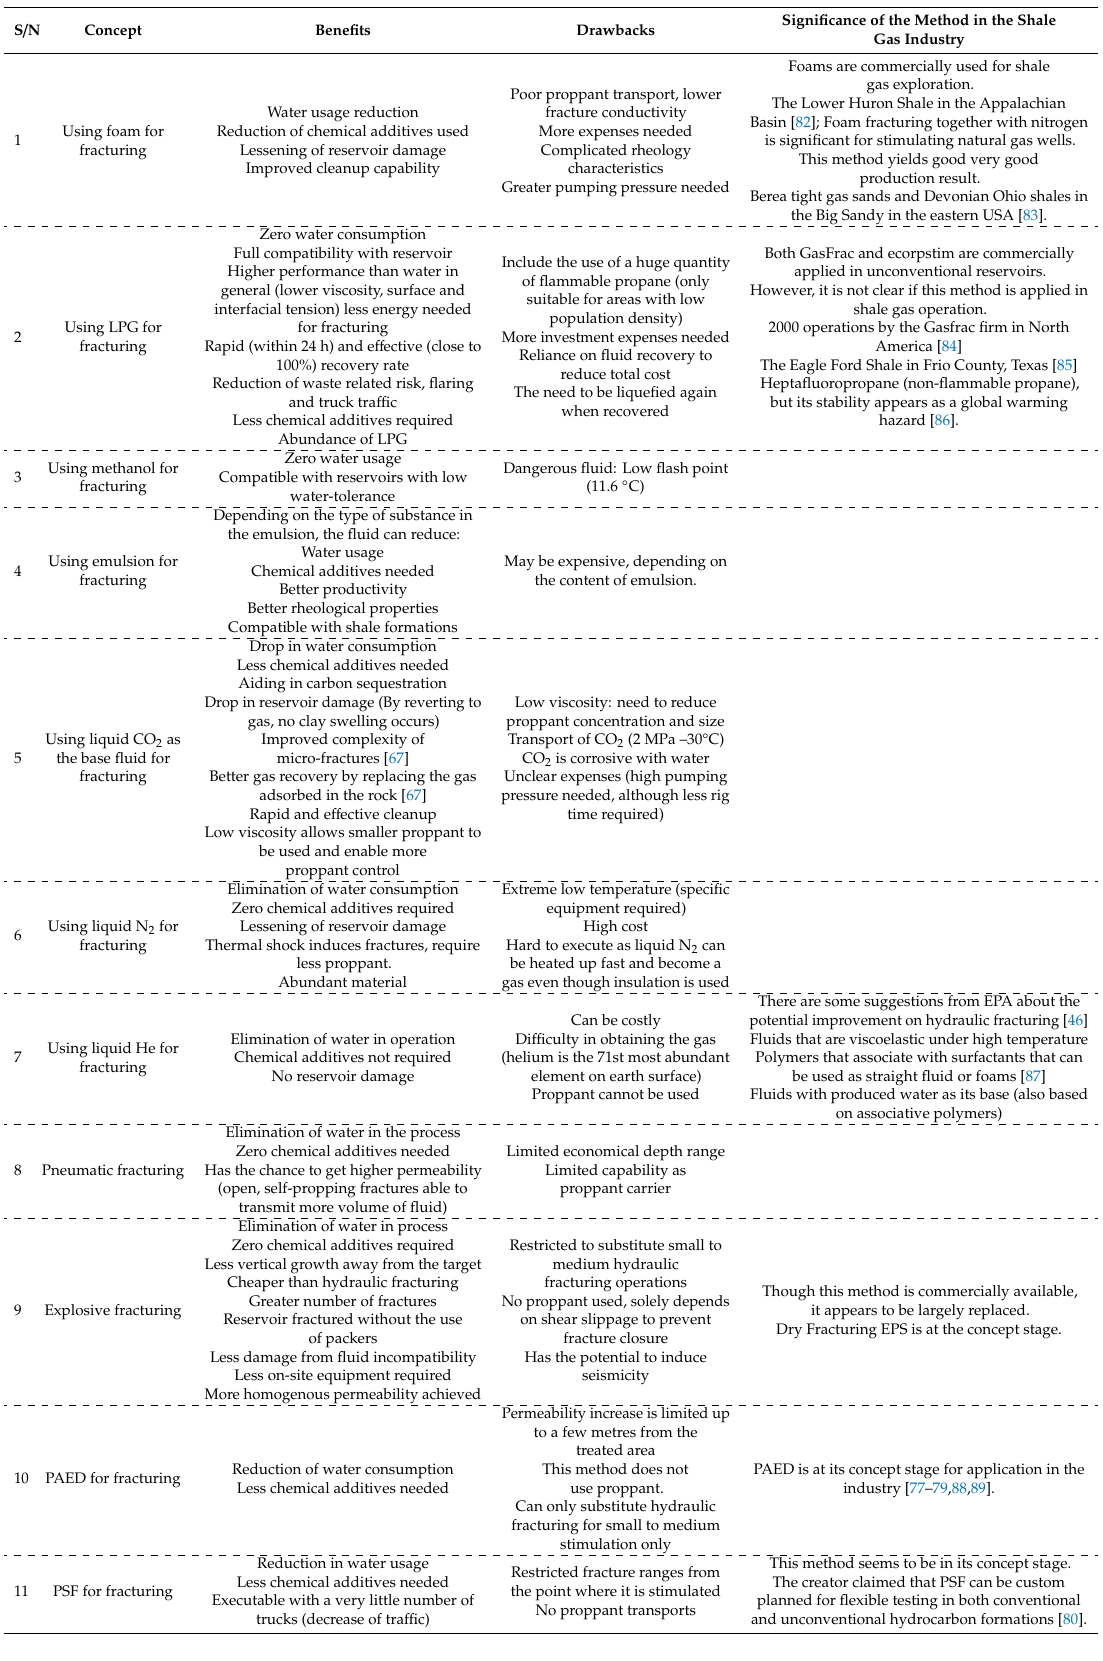
Table 3. Summary of the benefit and drawbacks of shale gas extraction